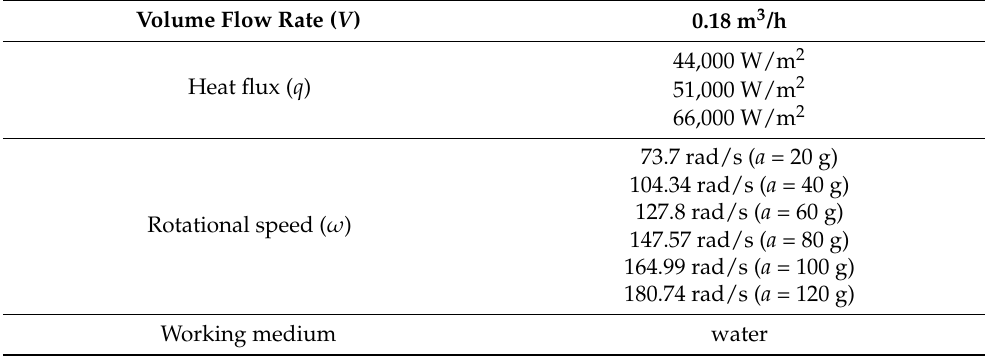
Table 1. working conditions used for numerical simulation.